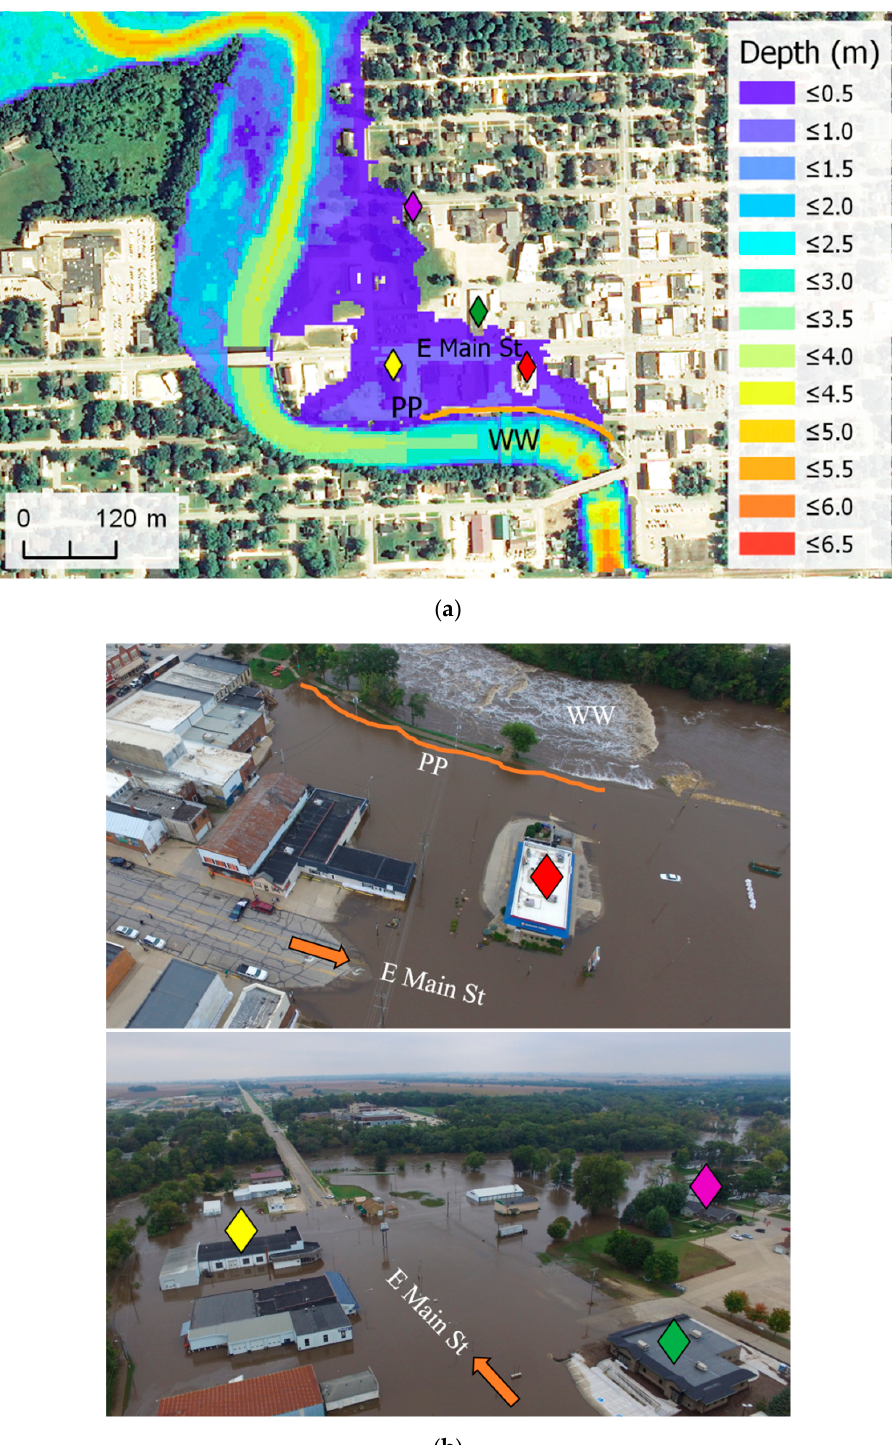
Figure 8. The nested model was used to simulate the flood of September 2016 in downtown Manchester. ( a ) The maximum depth output from XPSWMM (XP—C2—Stage IV) was compared to ( b ) photos and aerial images of flooding provided by the City of Manchester. The points of interest are indicated by colored diamond markers on both the photos and flood map. The orange arrow is pointing in the westbound direction along E Main Street. The newly built whitewater park in the Maquoketa River is labeled as WW and the pedestrian path (orange line labeled PP) is shown to impede stormwater flow from downtown into the river.